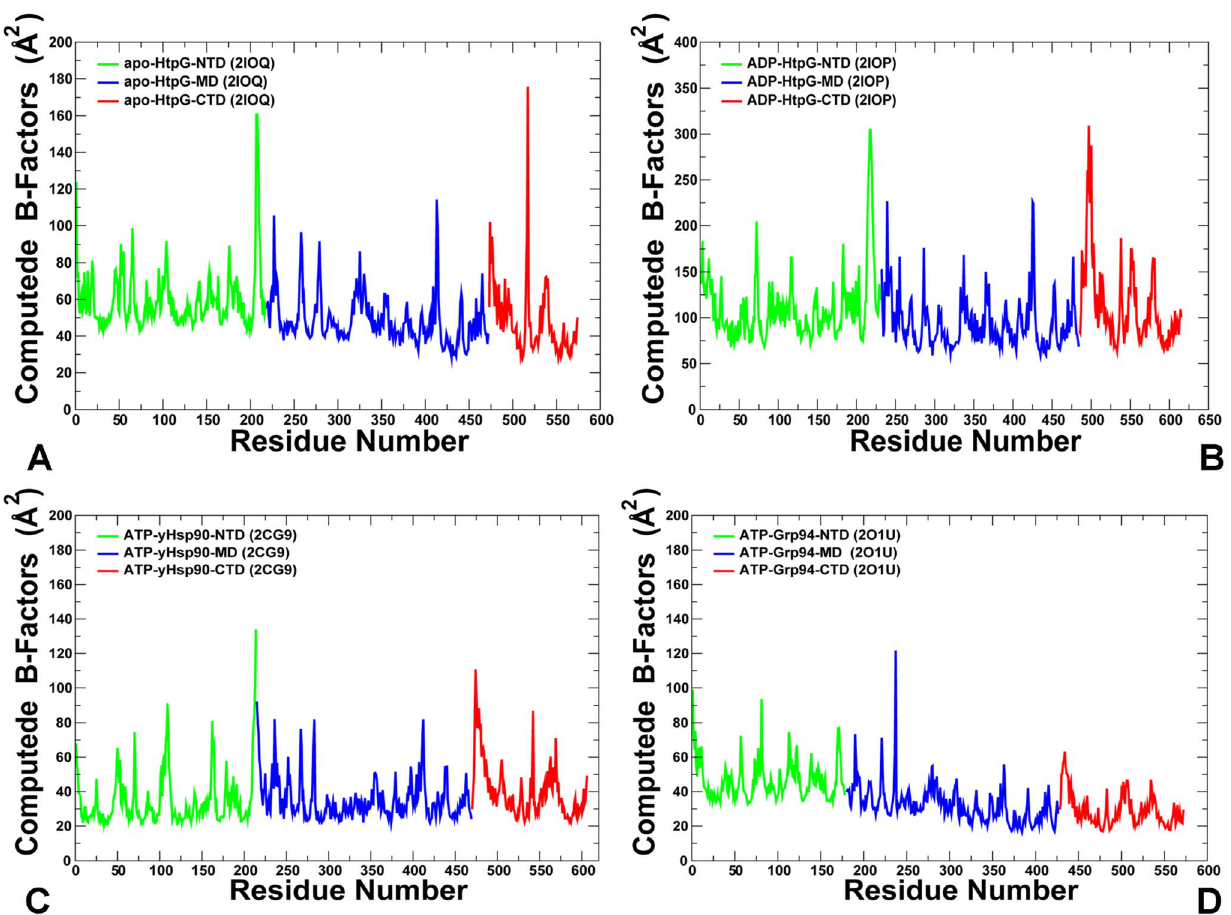
Figure 2. Conformational Dynamics of the Hsp90 Crystal Structures. The computed B-factors are obtained from MD simulations of apo- HtpG [56] (PDB ID 2IOQ) (A); ADP-bound HtpG [56] (PDB ID 2IOP) (B); ATP-bound yeast Hsp90 [55] (PDB ID 2CG9) (C); and ATP-bound Grp94 [61] (PDB ID 2O1U) (D). The NTD residues are shown in green, MD residues are in blue, and CTD residues are in red. The residue-based profiles are based on the consecutive residue numbering adopted from the original crystallographic residue annotation. For clarity, the equilibrium profiles are shown only for one monomer of the homodimer. (A) The fluctuation profile of the apo-HtpG crystal structure has the following residue annotation: NTD (residues 1– 219); MD (residues 220–474); CTD (residues 475–577). (B) The profile of the ADP-HtpG crystal structure has the following residue annotation: NTD (residues 1–231); MD (residues 232–486); CTD (residues 487–618). (C) The force constant profile of the yeast ATP-Hsp90 has the following residue annotation: NTD (residues 1–215); MD (residues 216–471); CTD (residues 472–609). (D) The force constant profile of the ATP-Grp94 crystal structure has the following residue annotation: NTD (residues 1–179); MD (residues 180–427); CTD (residues 428–573).